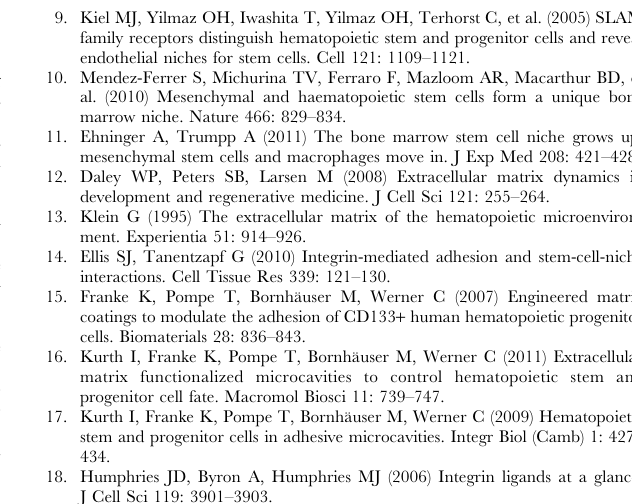
The FN type III 7–10 domain carries an N-terminal His-tag for biofunctionalization purposes. (B) The cRGD peptide with a PEG linker and a terminal cysteine. The thiol group of the cysteine side chain binds to a gold NP during biofunctionalization. Figure S2 Cell morphology on nanostructured PEG hydrogels. SEM images of critical point dried KG-1a cells on nanostructured, cRGD-functionalized hydrogels with interparticle distances of 30 6 6 nm. Magnification increases from A to C. Figure S3 KG-1a cell adhesion to cRGD functionalized hydrogels with different nanoparticle distances. Micro- scopic images of the border between the structured (bottom) and the unstructured (top) part of the nanostructured, cRGD functionalized hydrogels are shown. The distances between the gold NP on the different substrates are depicted above the pictures. Cells can be observed as bright spots on a grey background. Scale bar = 200 m m. Figure S4 Microscopic images of KG-1a cell adhesion to nanostructured hydrogels . The hydrogels were biofunctiona- lized with (A) FNRGD and (B) OPNs protein domains. NP distances are indicated above the panels. The images were taken at the border between the structured and the unstructured part of the substrates. One of 5 (A) or 3 (B) representative experiments is shown. Scale bar = 200 m m. Figure S5 Microscopic images of HSPC adhesion to FNRGD spots. Adhesion to the FNRGD domain (left) was inhibited by addition of a function-blocking b 1 integrin antibody (right). Cells appear as bright spots on a dark background. Figure S6 HSPC differentiation on nanostructured hydrogels. Differentiation of HSPCs on nanostructured hydro- gels (37 nm) functionalized with two different peptide ligands. N independent experiments = 3, error bars =standard deviation of the mean. Figure S7 HSPC proliferation assays. (A) Cell proliferation was measured on day 4 and day 7 using a CFSE assay and is